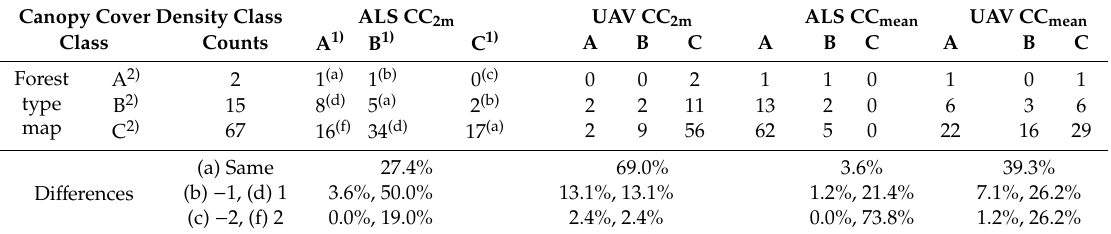
Table 13. Differences in canopy cover density between the forest type map and ALS and UAV measurements.